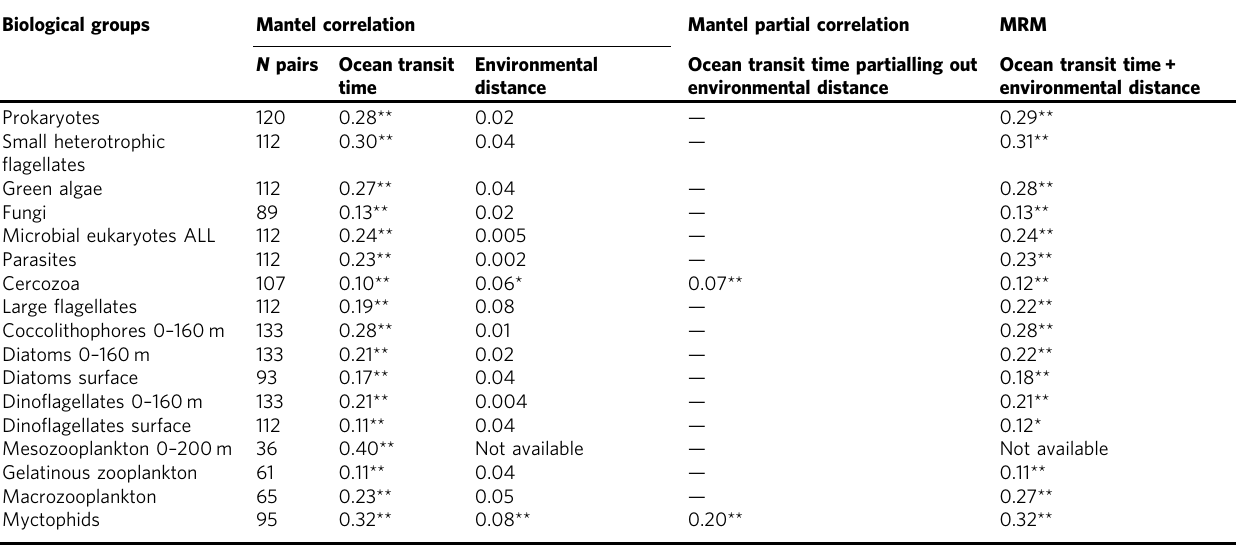
Table 1 Correlations between community similarity with currents and environmental factors Biological groups Mantel